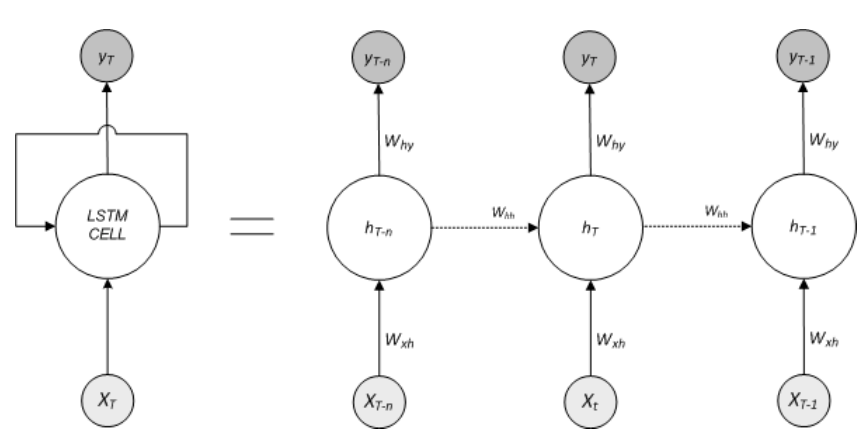
Figure 2. Standard unfold structure of single LSTM (Long Short-Term Memory) cell architecture working with time T steps.